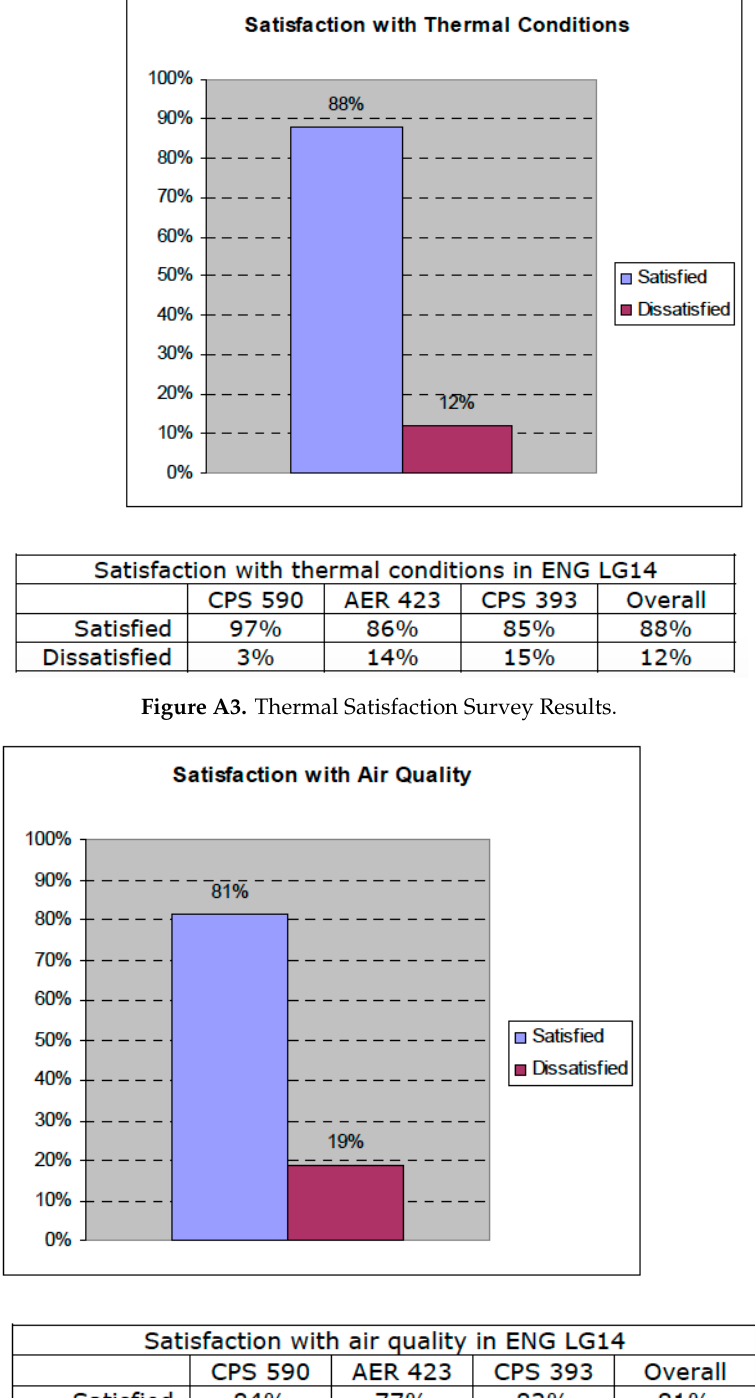
Figure A2. Thermal Sensation Survey Results. Note that CPS 590, AER 423, and CPS 393 are lecture course codes respectively.